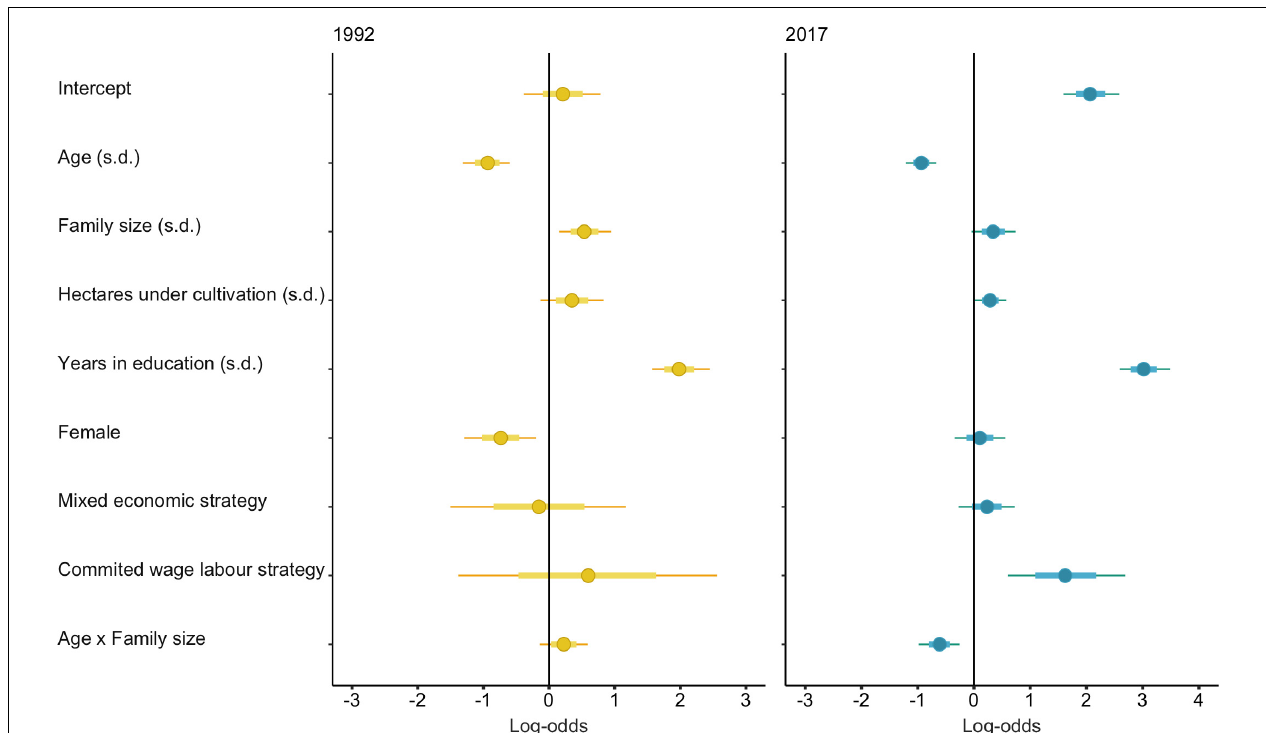
FIGURE 3 | Log-odds from the posterior distribution of the full multilevel logistic mixed model showing the probability that an individual spoke Spanish in 1992 (left) and 2017 (right) . Points show median probability that an individual spoke Spanish, thick lines are 50% HPDIs, and thin lines are 90% HPDIs. A vertical line represents no effect. All continuous parameters are standardized within each time period. The effects of a mixed economic strategy and of a committed wage labor strategy are reported in relation to the effects of a committed agricultural strategy (the reference